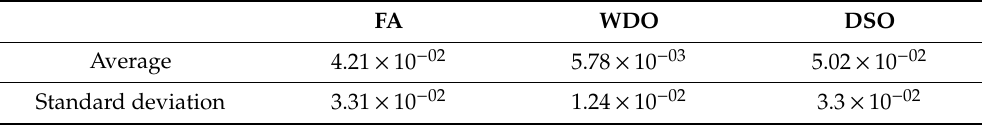
Table 18 summarized the results of the optimization methods. Table 18. Summary of results from the optimization